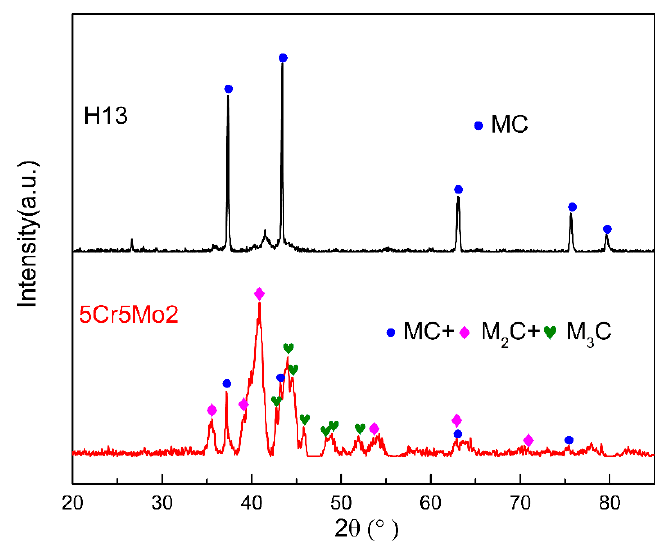
Figure 8. X-ray diffraction (XRD) patterns of the carbide powder extracted from the 5Cr5Mo2 and Figure 8. X-ray di ff raction (XRD) patterns of the carbide powder extracted from the 5Cr5Mo2 and H13 steels. H13